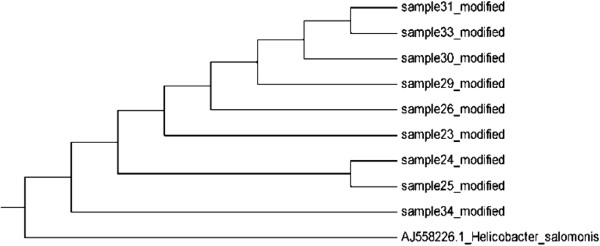
Helicobacteraceae DNA was detected with single PCR in all the colonic biopsies: Evolutionary relationships of taxa for
helicobacter salomonis
the evolutionary history was inferred using the UPGMA, Kimura 2-parameter and MEGA5 methods.